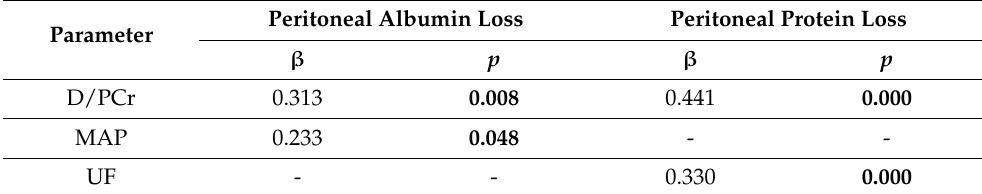
Table 4. Multivariate association between peritoneal albumin and protein loss and patient character- istics in non-diabetics. Peritoneal Albumin Parameter